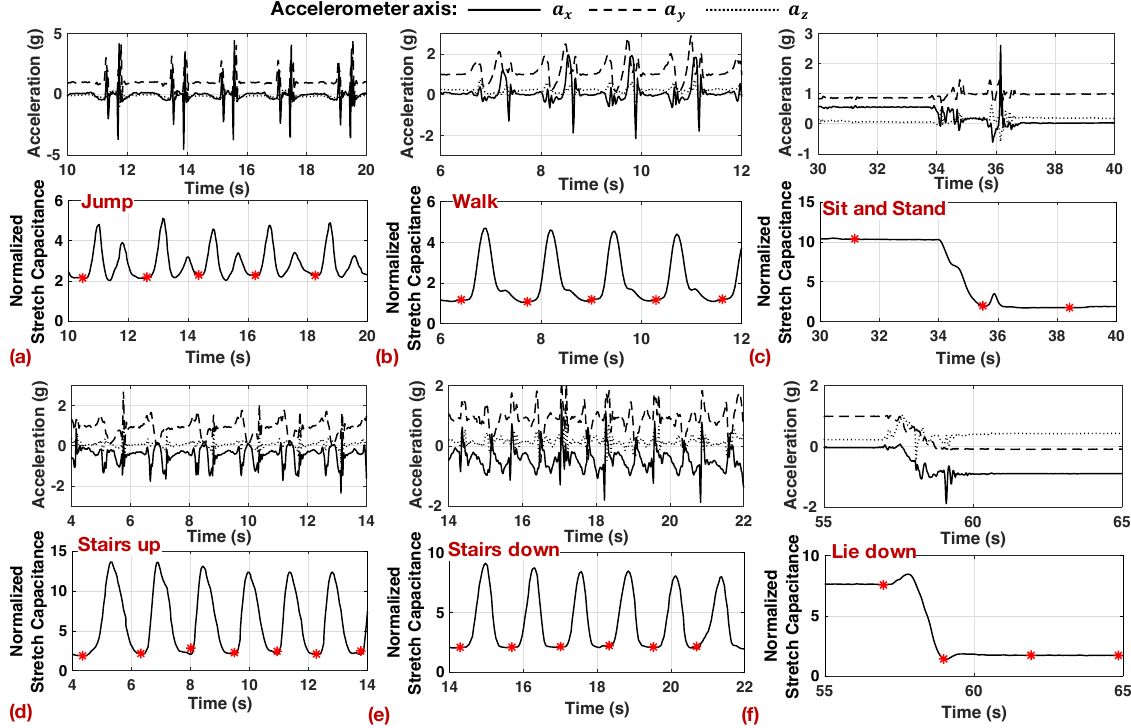
Figure 3. Demonstration of the segmentation algorithm for ( a ) jump, ( b ) walk, ( c ) sit and stand, ( d ) stairs up, ( e ) stairs down, and ( f ) lie down activities in the w-HAR